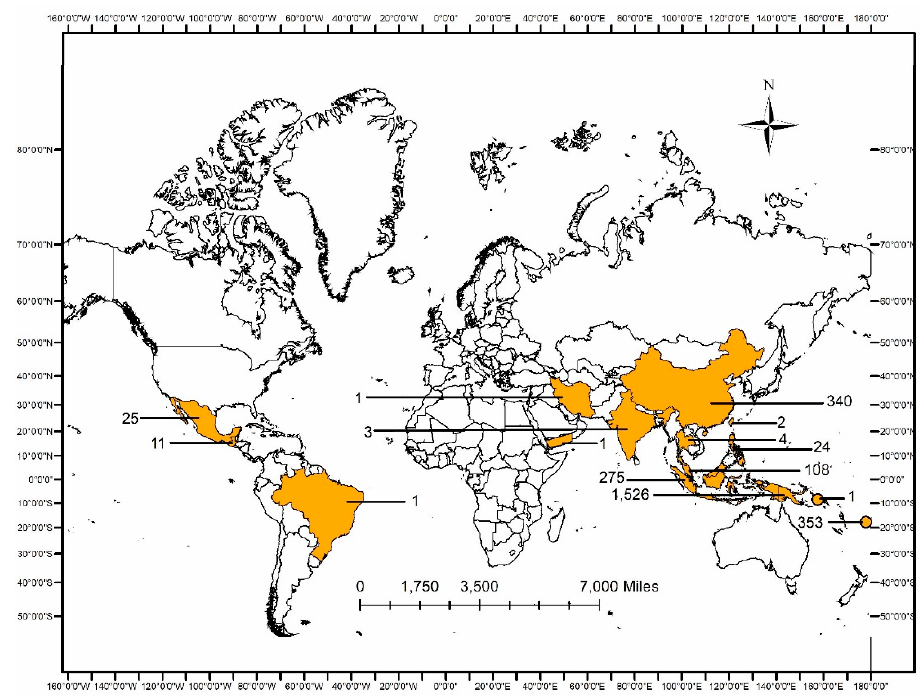
Figure 2. Number of reported cases of tinea imbricata around the globe, based on published arti- cles.